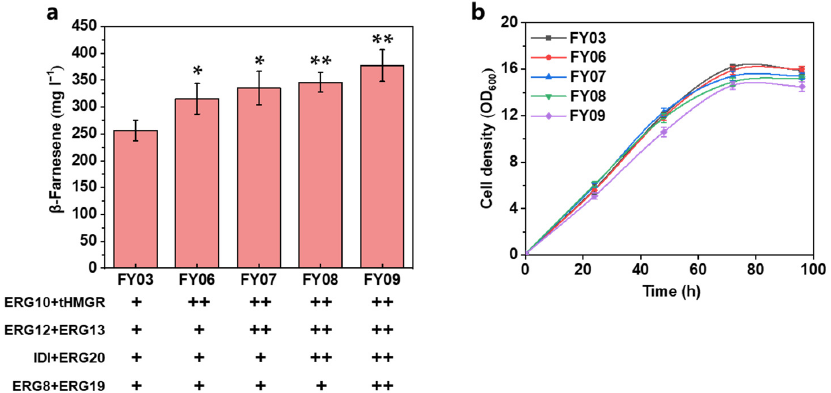
Figure 3. Second-round overexpression of eight genes in MVA pathway. ( a ) β -Farnesene production by iterative reinforcement of MVA pathway genes and ( b ) cell density. Each black plus sign represents a copy. β -Farnesene was detected at 96 h of fermentation. Data are represented as mean ± standard deviation (n = 3). Statistically significant differences between each engineered β -farnesene production strain and control strain (NC) are noted (two-tailed t -test; * p < 0.05, ** p < 0.01). ns—not significant.